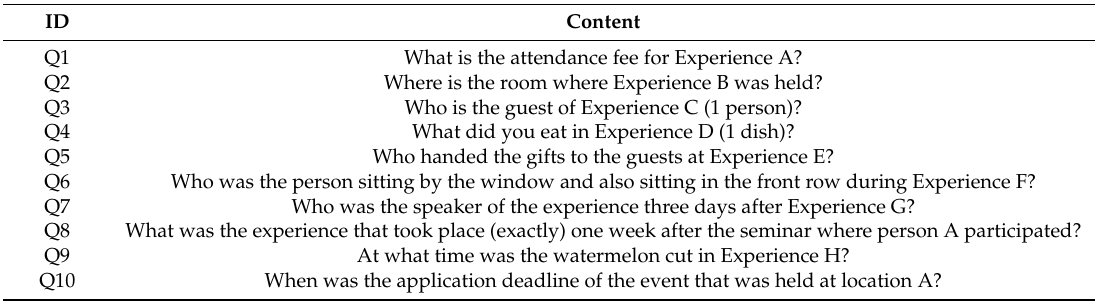
Table 8. Content of the questions that were presented in Experiment 2-1.